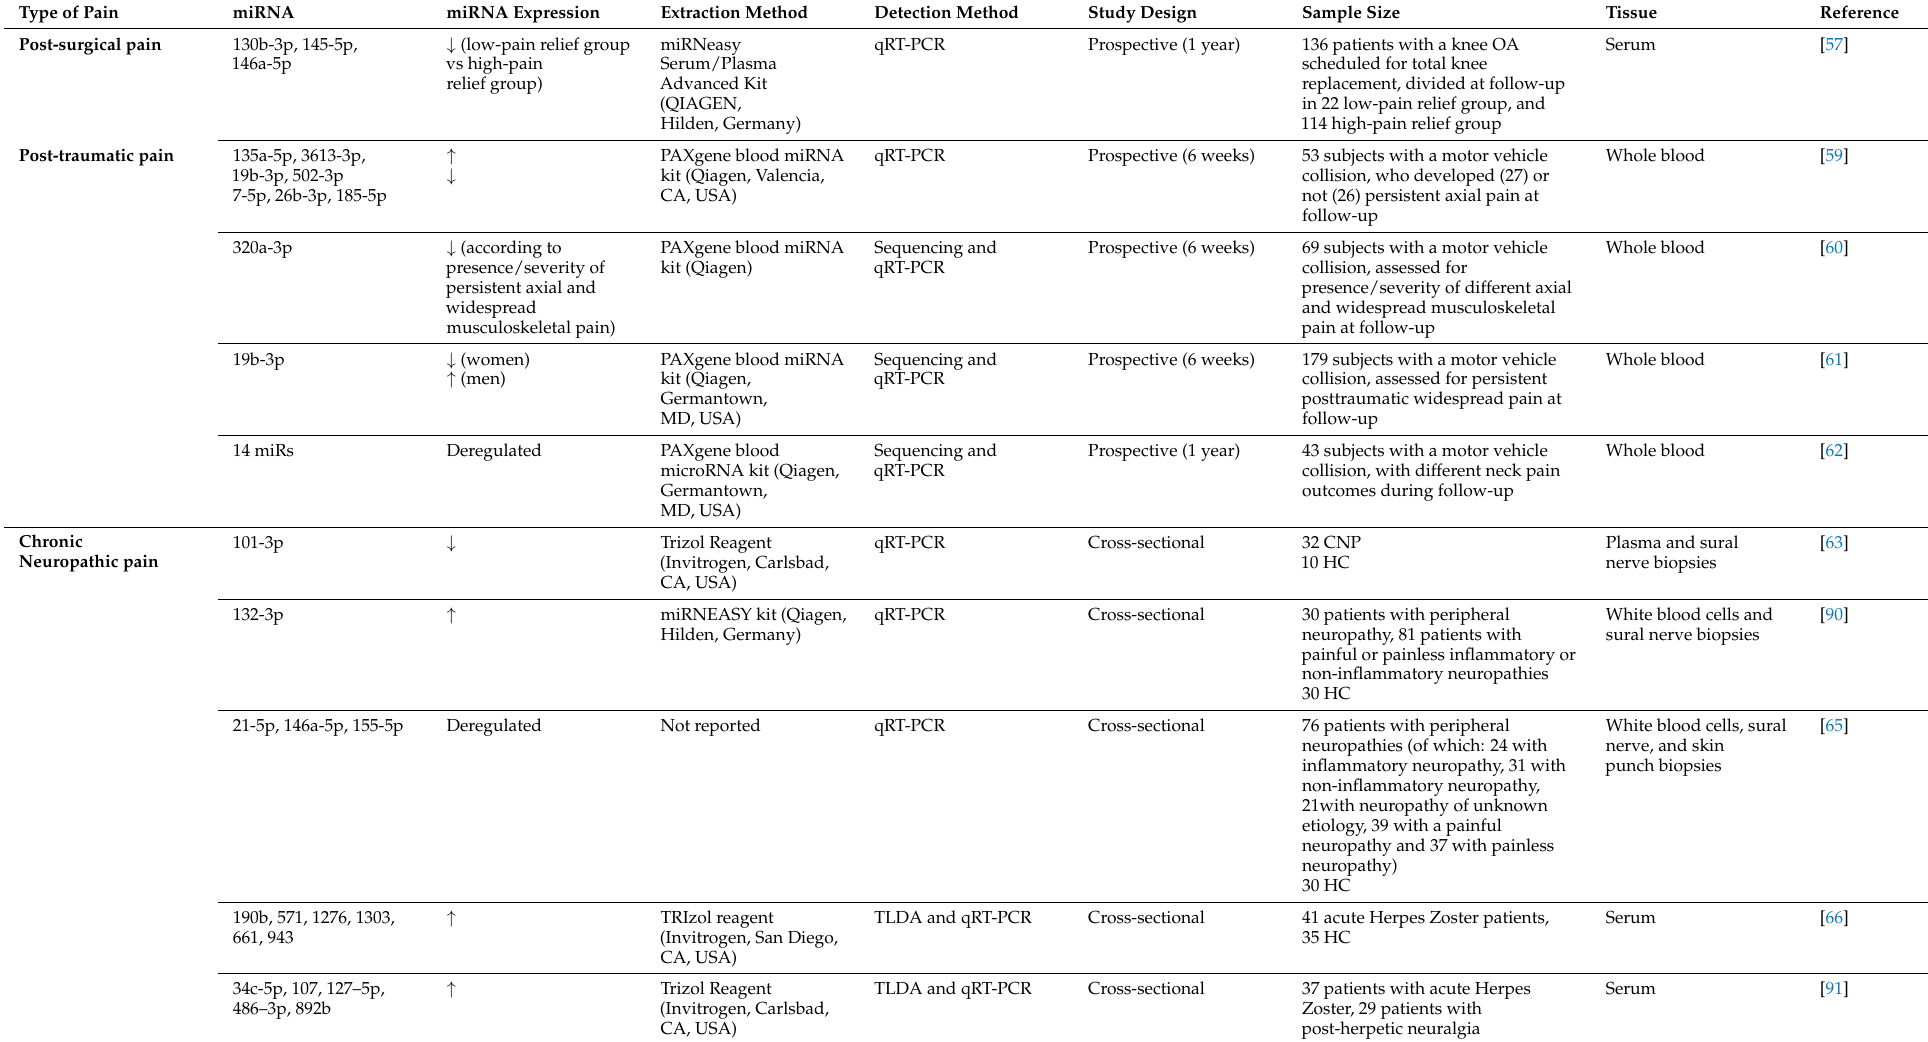
Table 3. MiRNA dysregulation related to chronic secondary